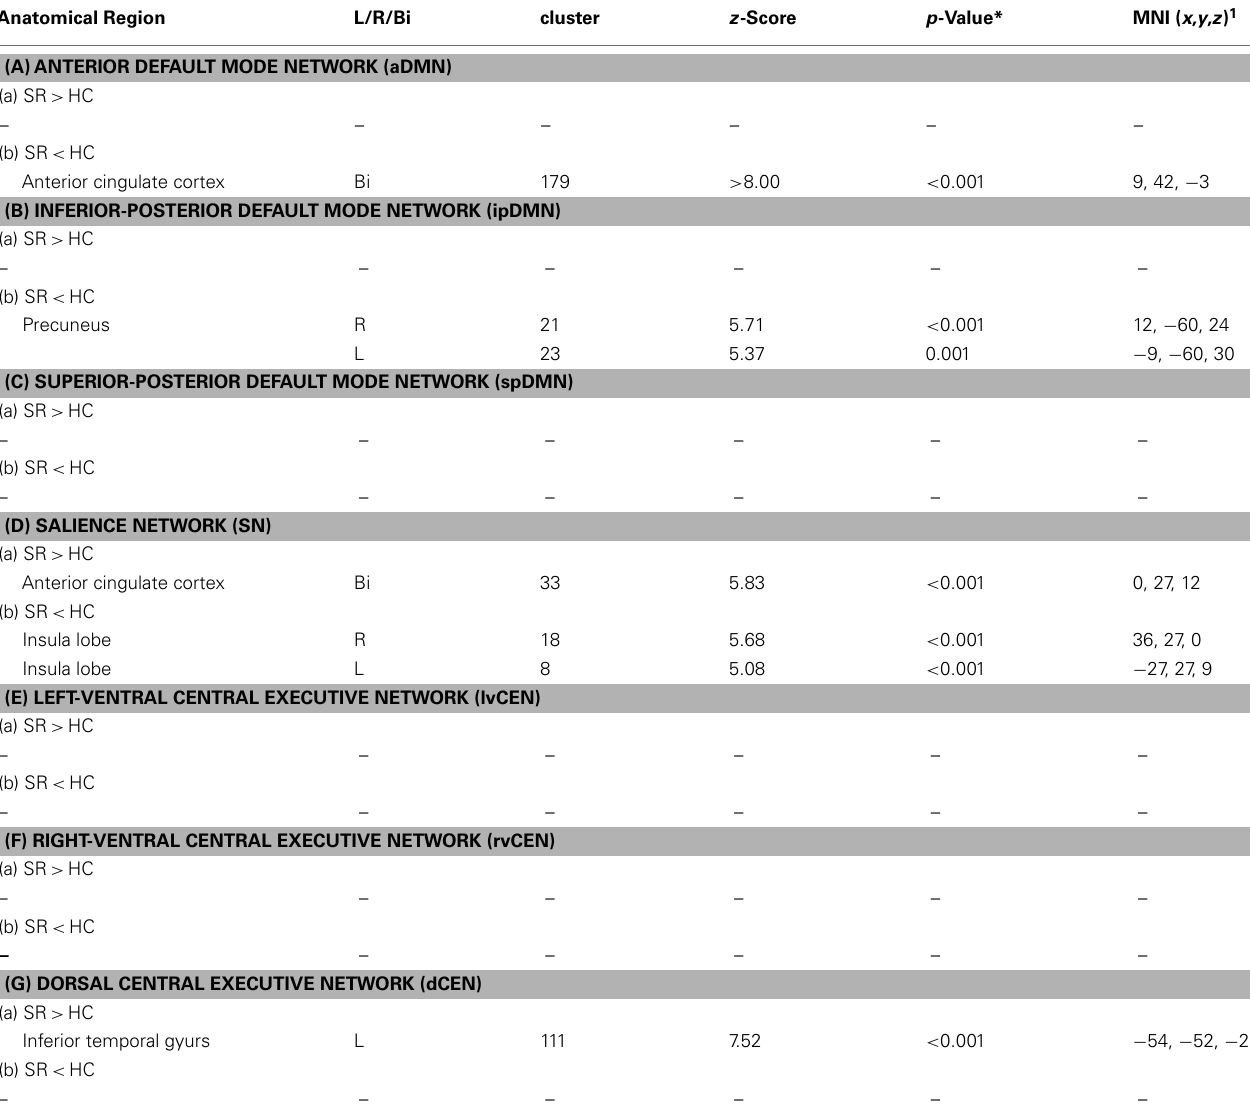
Table 4 |Altered intra-iFC in patients with schizophrenia in state of remission compared to healthy controls. Anatomical